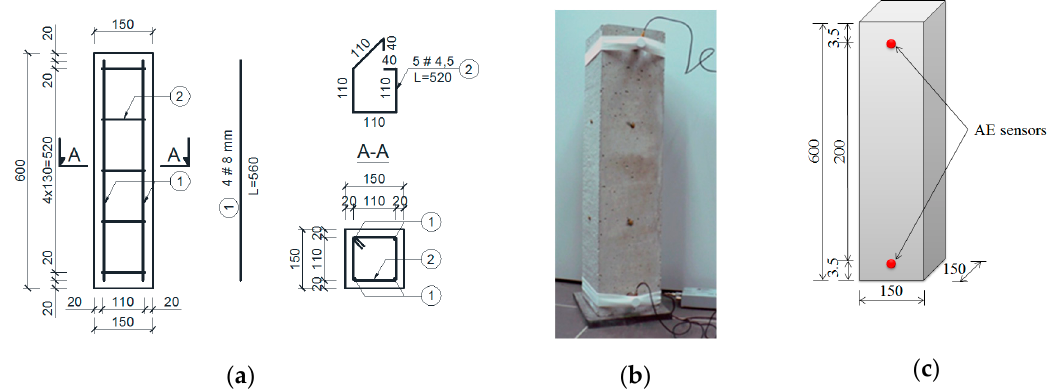
Figure 3. ( a ) Schematic diagram of reinforcement of W4 samples; ( b ) sample during the test; and ( c ) acoustic emission (AE) sensor arrangement (unit: mm).